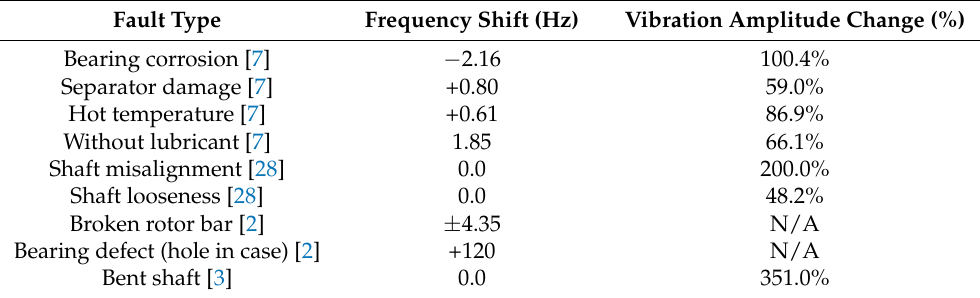
Table 1. Effects of different faults on the vibration